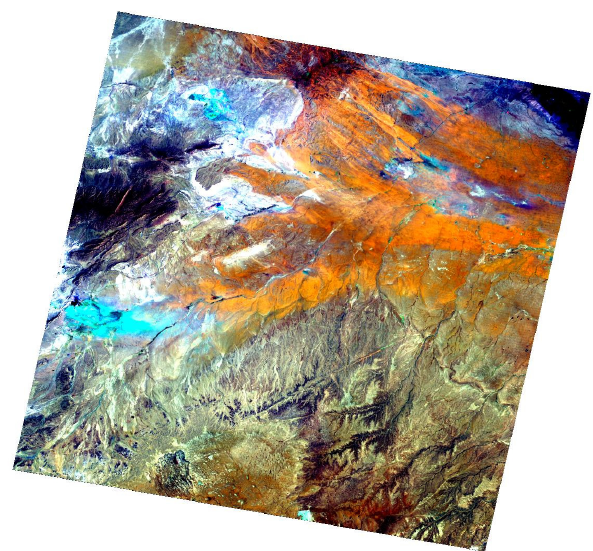
Figure 7. Landsat-4 TM-image 172/36 (WRS-2), date 01.09.1990, channel 741.